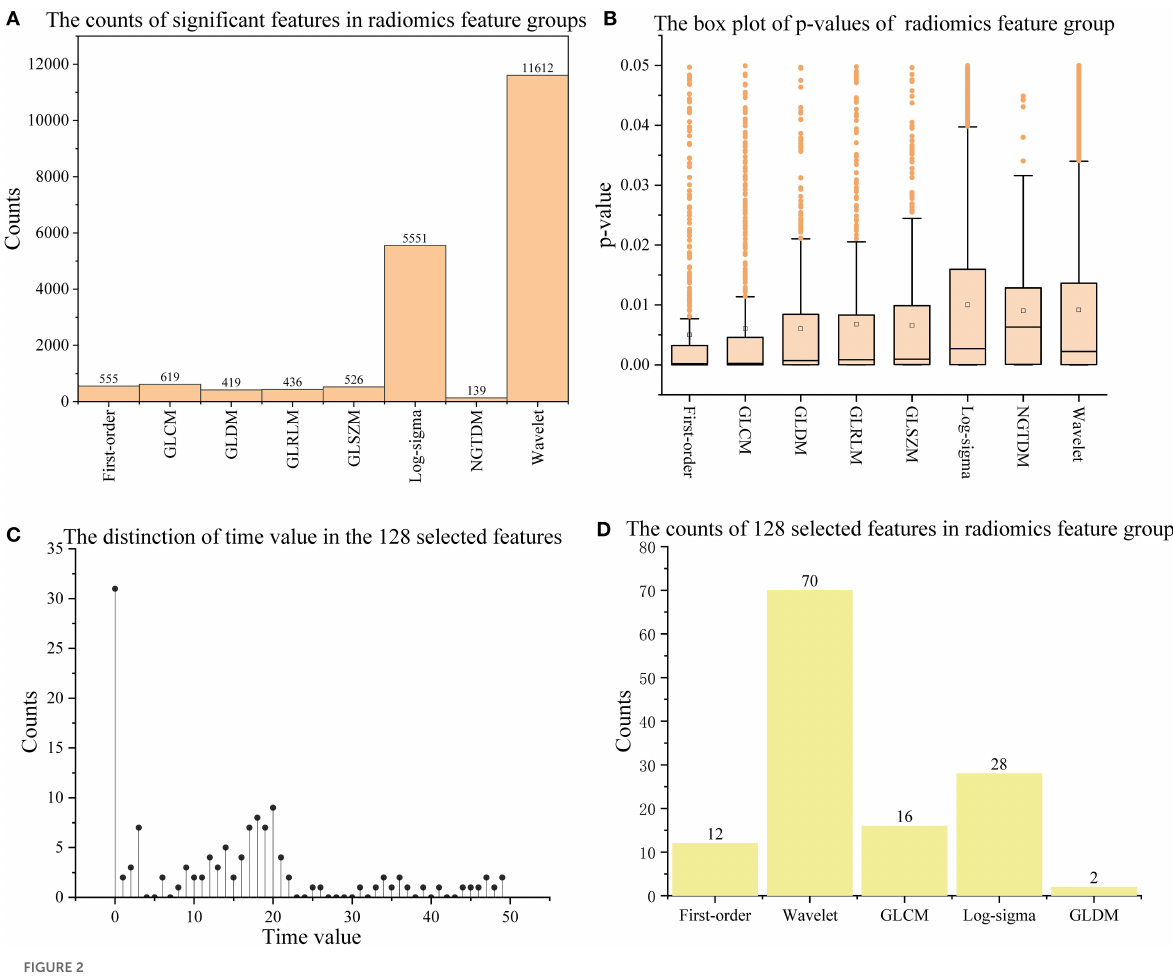
The ability to identify the proportion of ischemic stroke In the 120 F RT_S formed by the F top 6 of the three S slices under 40 RT , positive samples (label = 1) indicated that ischemic stroke volume greater than RT differed. Figure 5A shows the distribution of positive samples in each S with different RT values. In each case, positive samples decreased gradually as RT values increased. In general, the ratio of positive samples in 160 patients ranged from 15 to 61.25% in S = 3, 17.5–61.88% in S = 4, and 11.88–63.13% in S = 5. When RT was in the range of 0– 0.04, the proportion between positive and negative samples was > 1:1; when RT was in 0.05–0.1, the proportion was about 2:3; when RT was in 0.11–0.25, the proportion was nearly 1:3, and when RT was > 0.25, the proportion was <